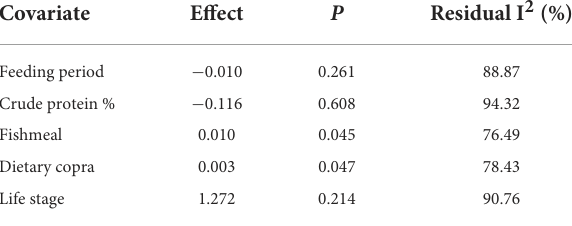
TABLE 9 Meta-regression for protein